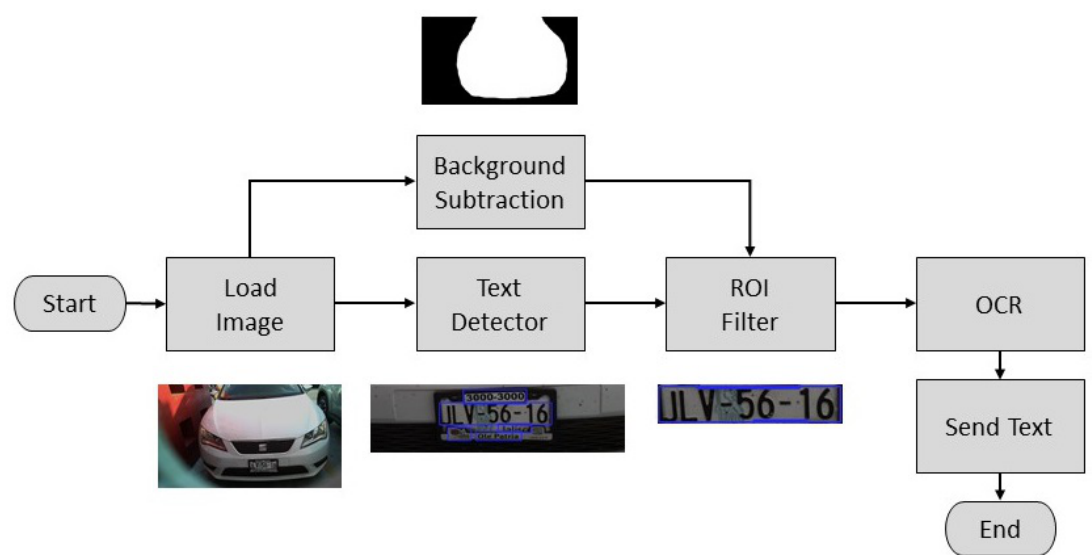
Figure 19. Diagram of the license plate recognition